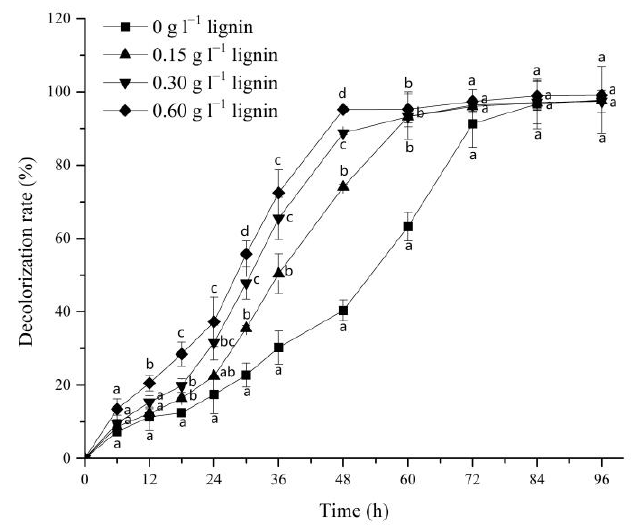
Figure 1. Decolorization rate of Direct Red 5B (DR5B) by G. lucidum EN2 in the presence of different contents of alkali lignin (0, 0.15, 0.30, and 0.60 g L − 1 ). The vertical line on each bar indicates the standard deviation for three replicates (SD, n = 3). Different letters represent significant differences between treatment groups at each time point, as determined with two-way ANOVA followed by LSD or Tukey multiple comparison tests ( p <